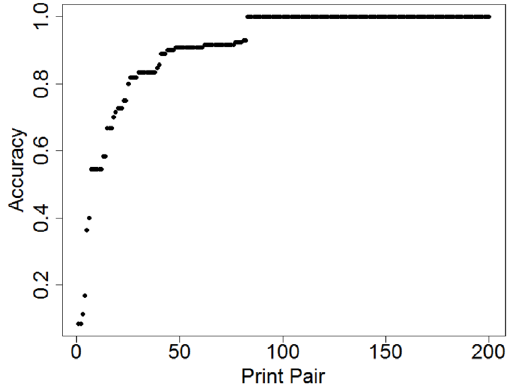
Figure 3. Sorted average accuracy for each print pair. Print pairs are numbered along the x-axis from 1–200 in order of increasing accuracy.